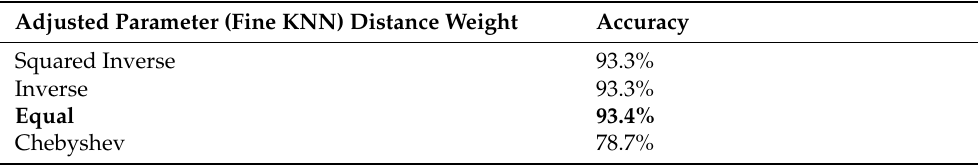
Table 3. Adjusted parameters of vocabulary bank results (100